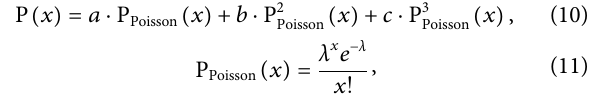
Frontiers in Physics |